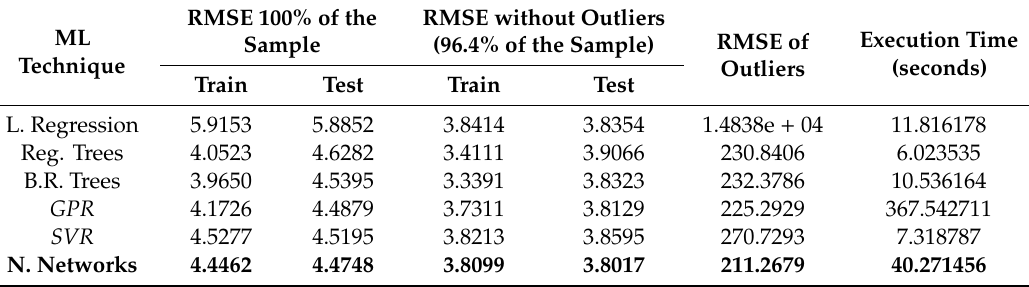
Table 9. BMI-CTDI VOL results for women’s Abdomen & Pelvis protocol.